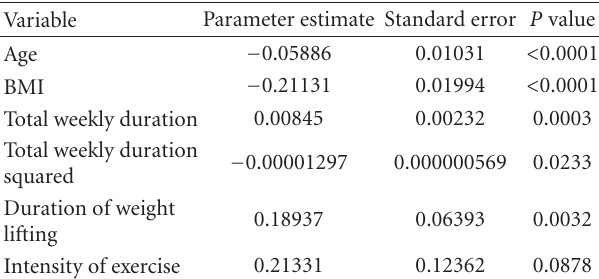
Table 2: Linear regression model describing Cardiorespiratory fitness (maximal achieved METS) (in randomly assigned training set n = 405).